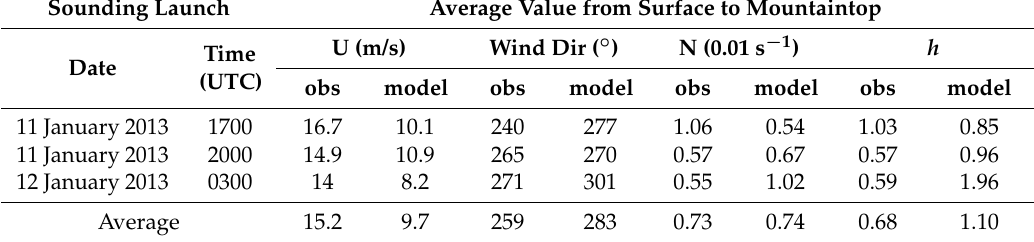
Table 2. Characterization of the upwind environment, and evaluation of model performance. Shown are the wind speed U , wind direction, the Brunt–Väisälä frequency N , and the Froude number Fr . All observations (OBS) are derived from a radiosondes released in Saratoga and model output is time–space-matched to these observations. Here N is the depth-weighted average dry (moist) value of the Brunt–Väisälä frequency below (above) cloud base (defined as the LCL). The non-dimensional mountain height h is calculated as NH where H is the height of Medicine Bow Peak (3,661 m MSL) U